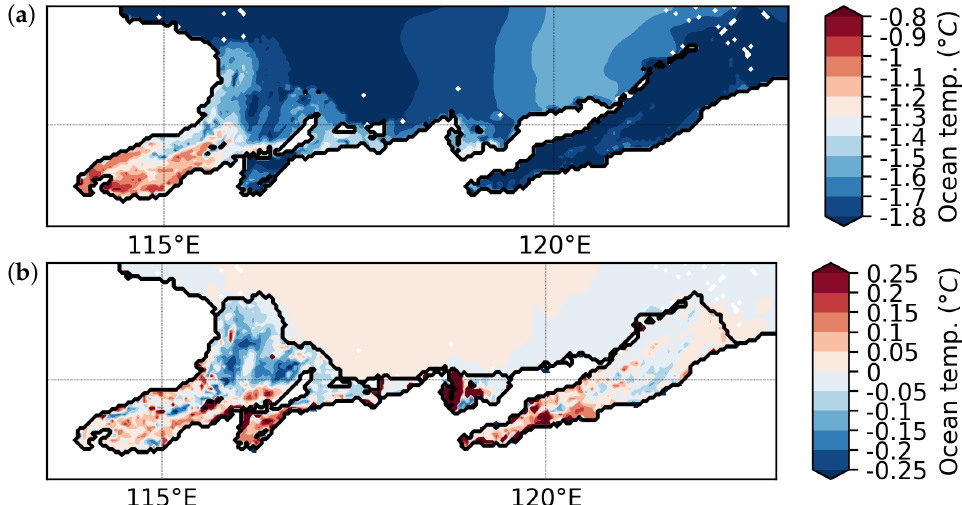
Figure 5. Mean ocean temperature at the ice–ocean interface in REF ( a ). Differences in ocean temperature at the ice–ocean interface between REF3mcpl and REF ( b ), averaged over